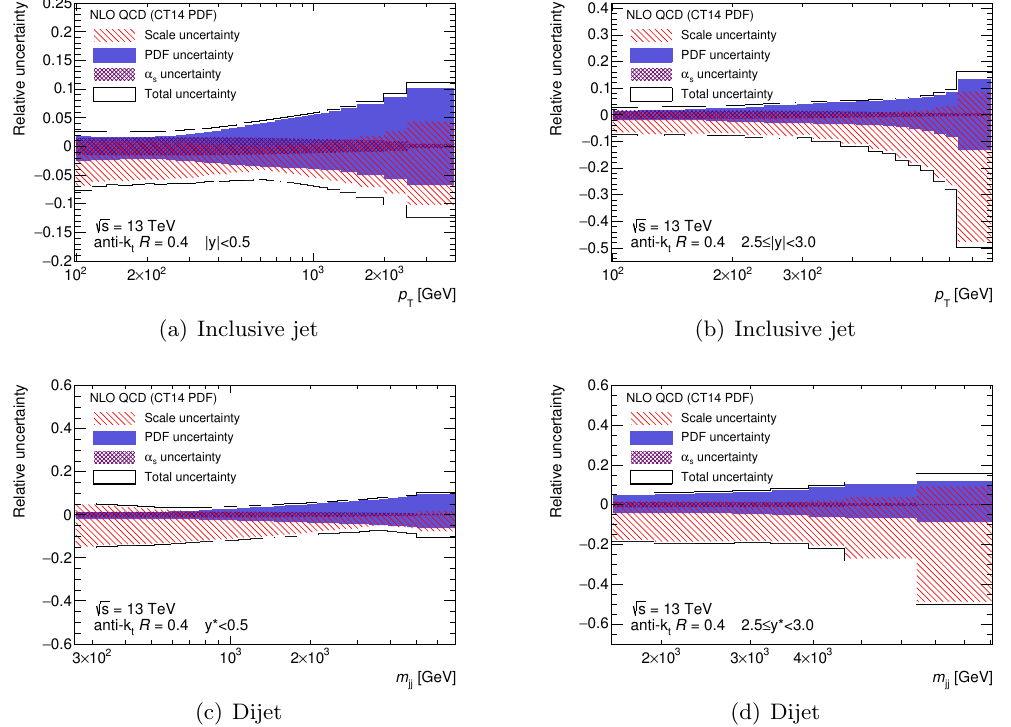
Figure 2 . Relative NLO QCD uncertainties in the jet cross-sections calculated using the CT14 PDF set. Panels a,b (c,d) correspond respectively to the (cid:12)rst and last j y j ( y (cid:3) ) bins for the inclusive jet (dijet) measurement. The uncertainties due to the renormalisation and factorisation scale, the (cid:11) s , the PDF and the total uncertainty are shown. The total uncertainty, calculated by adding the individual uncertainties in quadrature, is shown as a black